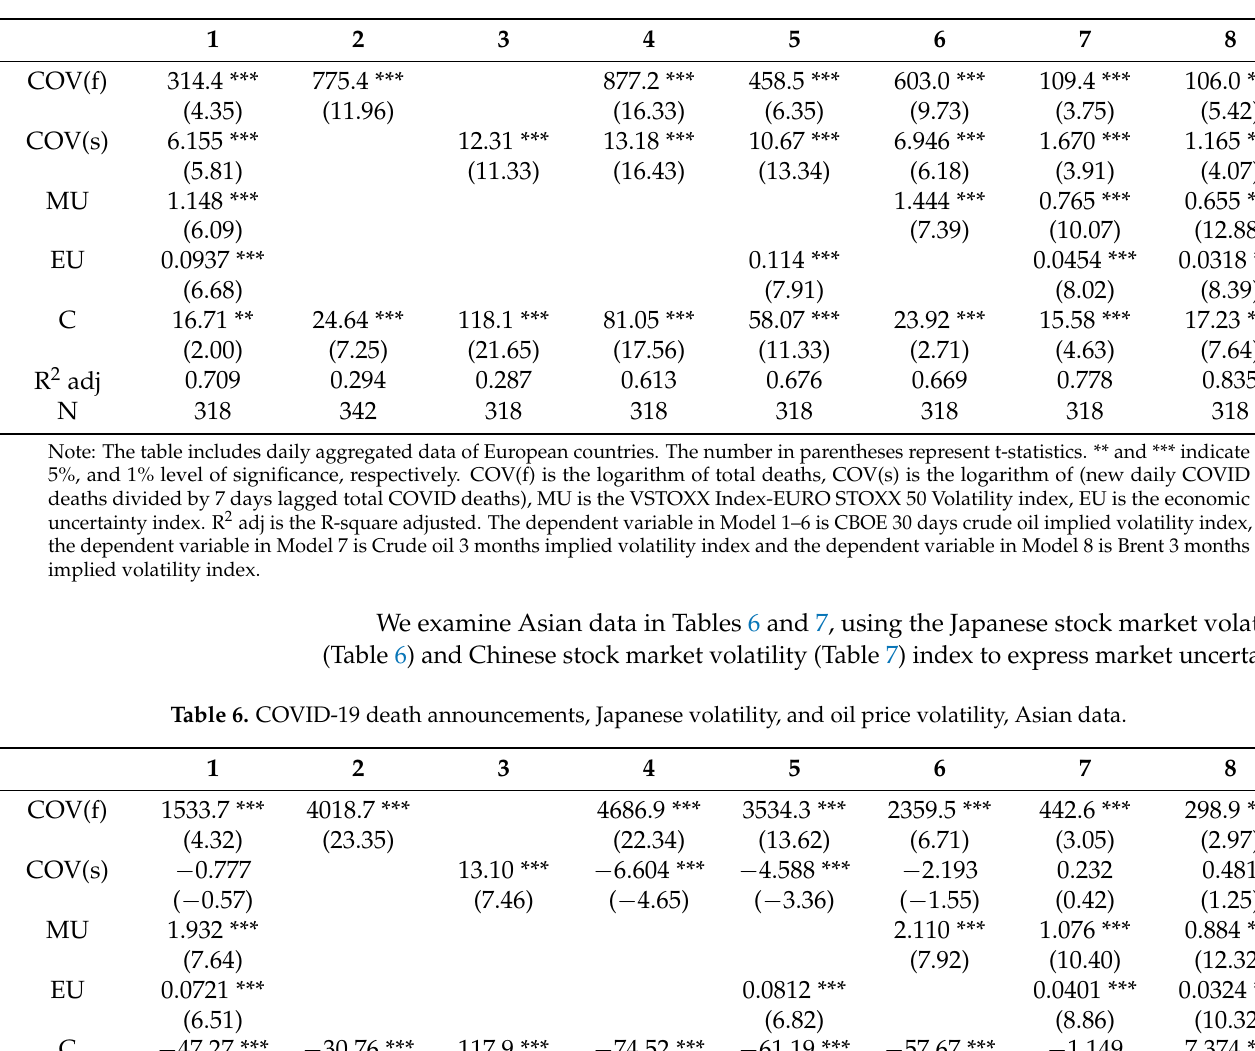
Table 5. COVID-19 death announcements, European volatility, and oil price volatility, European data.